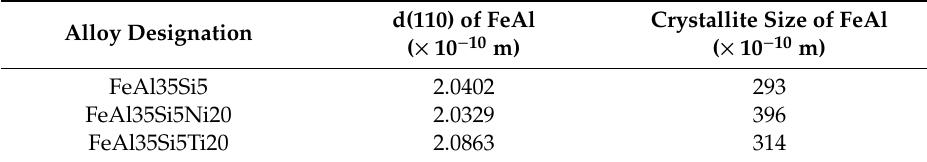
Table 2. Interplanar distance of the (110) planes in the FeAl phase and the crystallite size of the FeAl phase in tested alloys.